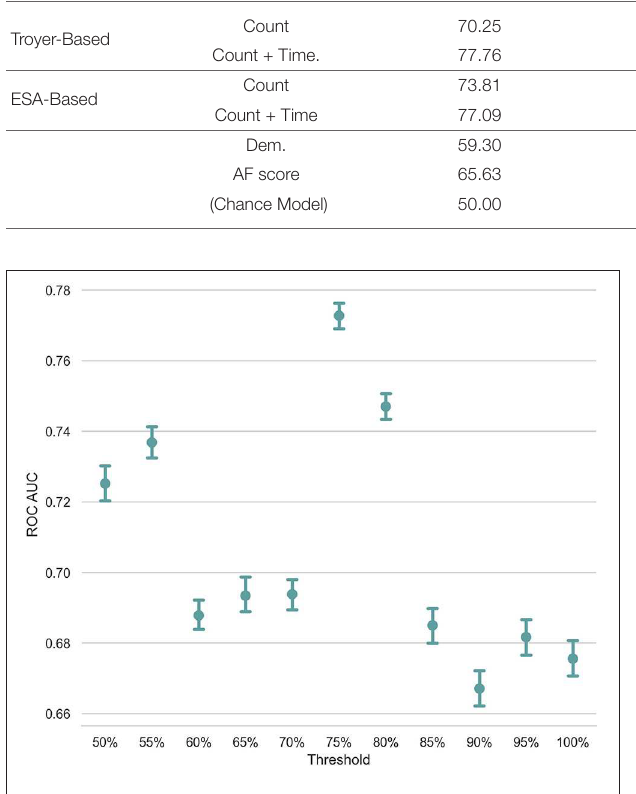
FIGURE 4 | The x-axis is the different threshold setting ( xx % ) of mean cosine similarity of an individual’s answer. The y-axis is the ROC AUC